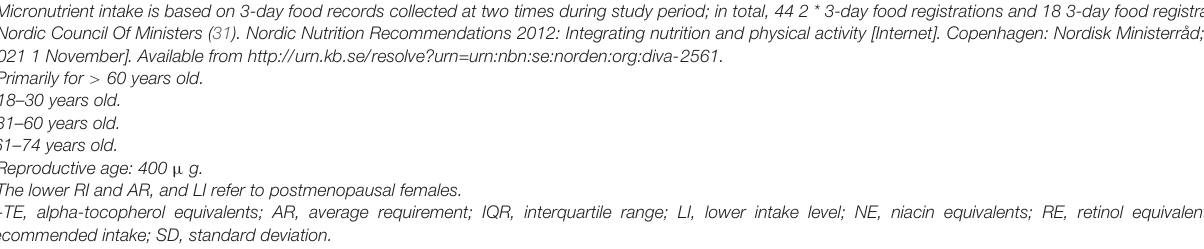
a Micronutrient intake is based on 3-day food records collected at two times during study period; in total, 44 2 * 3-day food registrations and 18 3-day food registrations. b Nordic Council Of Ministers (31). Nordic Nutrition Recommendations 2012: Integrating nutrition and physical activity [Internet]. Copenhagen: Nordisk Ministerråd; [cited